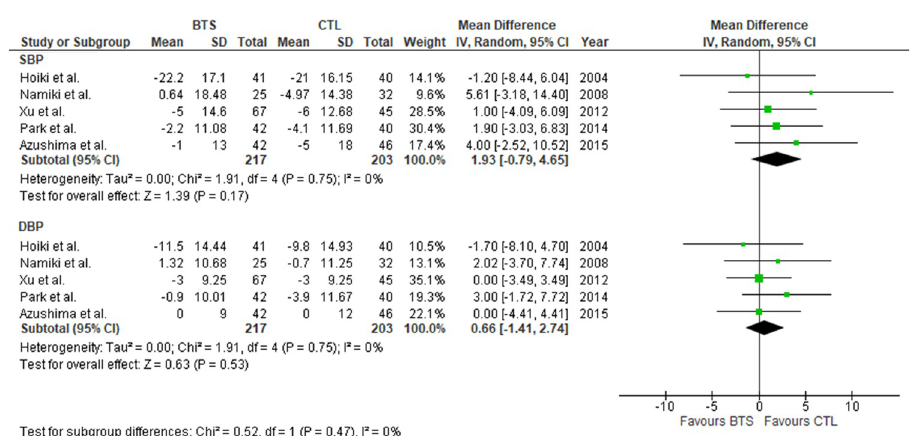
Fig 6. Meta-analysis of the effects of BTS on blood pressure. (A) Systolic blood pressure. (B) Diastolic blood pressure. BTS, bofutsushosan group; CTL, control group. https://doi.org/10.1371/journal.pone.0266917.g006 BMI in participants with obesity (MD [95% CI]: − 0.70 kg/m 2 [ − 1.35, − 0.05], P = 0.03). Consid- erable heterogeneity was observed in both analyses ( I 2 = 89%, P = 0.0001; I 2 = 78%, P = 0.003, respectively). Fourth, we considered the laxative effect of BTS on BMI reduction. Among the crude drugs of BTS, Rhei Rhizoma, a traditional laxative, could affect participants’ BMI. In our study, three trials by Hioki, Xu, and Murase adopted placebos containing laxative components. Thus, we performed a sensitivity analysis to compare the BTS and these three groups. There was a significant BMI improvement in the BTS group relative to the controls using laxative pla- cebos (MD [95% CI]: -0.85 kg/m 2 [ − 1.64, − 0.06], P = 0.03) with considerable heterogeneity ( I 2 = 85%, P = 0.001). Finally, we focused on the contents of BTS. One study [21] used a BTS extract with a higher dose of crucial drugs than that in the other studies (S1 Table). We